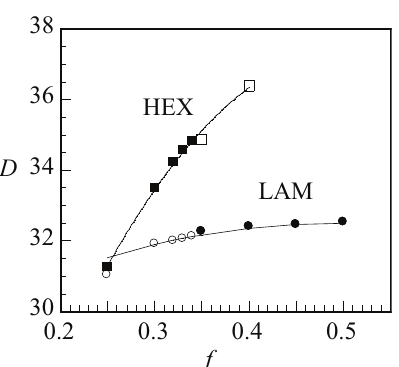
Figure 9. Optimal spacing ( D ) of LAM and HEX phases as a function of composition ( f ) for N = 300 and χ N = 30. For LAM phase, the fit of D ∝ f 2/3 + ( 1 − f ) 2/3 is drawn to guide the eye. Open and closed symbols refer to the metastable and stable points,